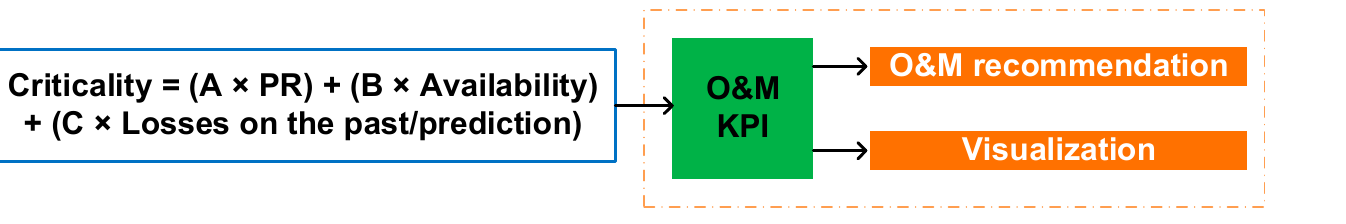
Figure 6. Definition of KPI for the generation of